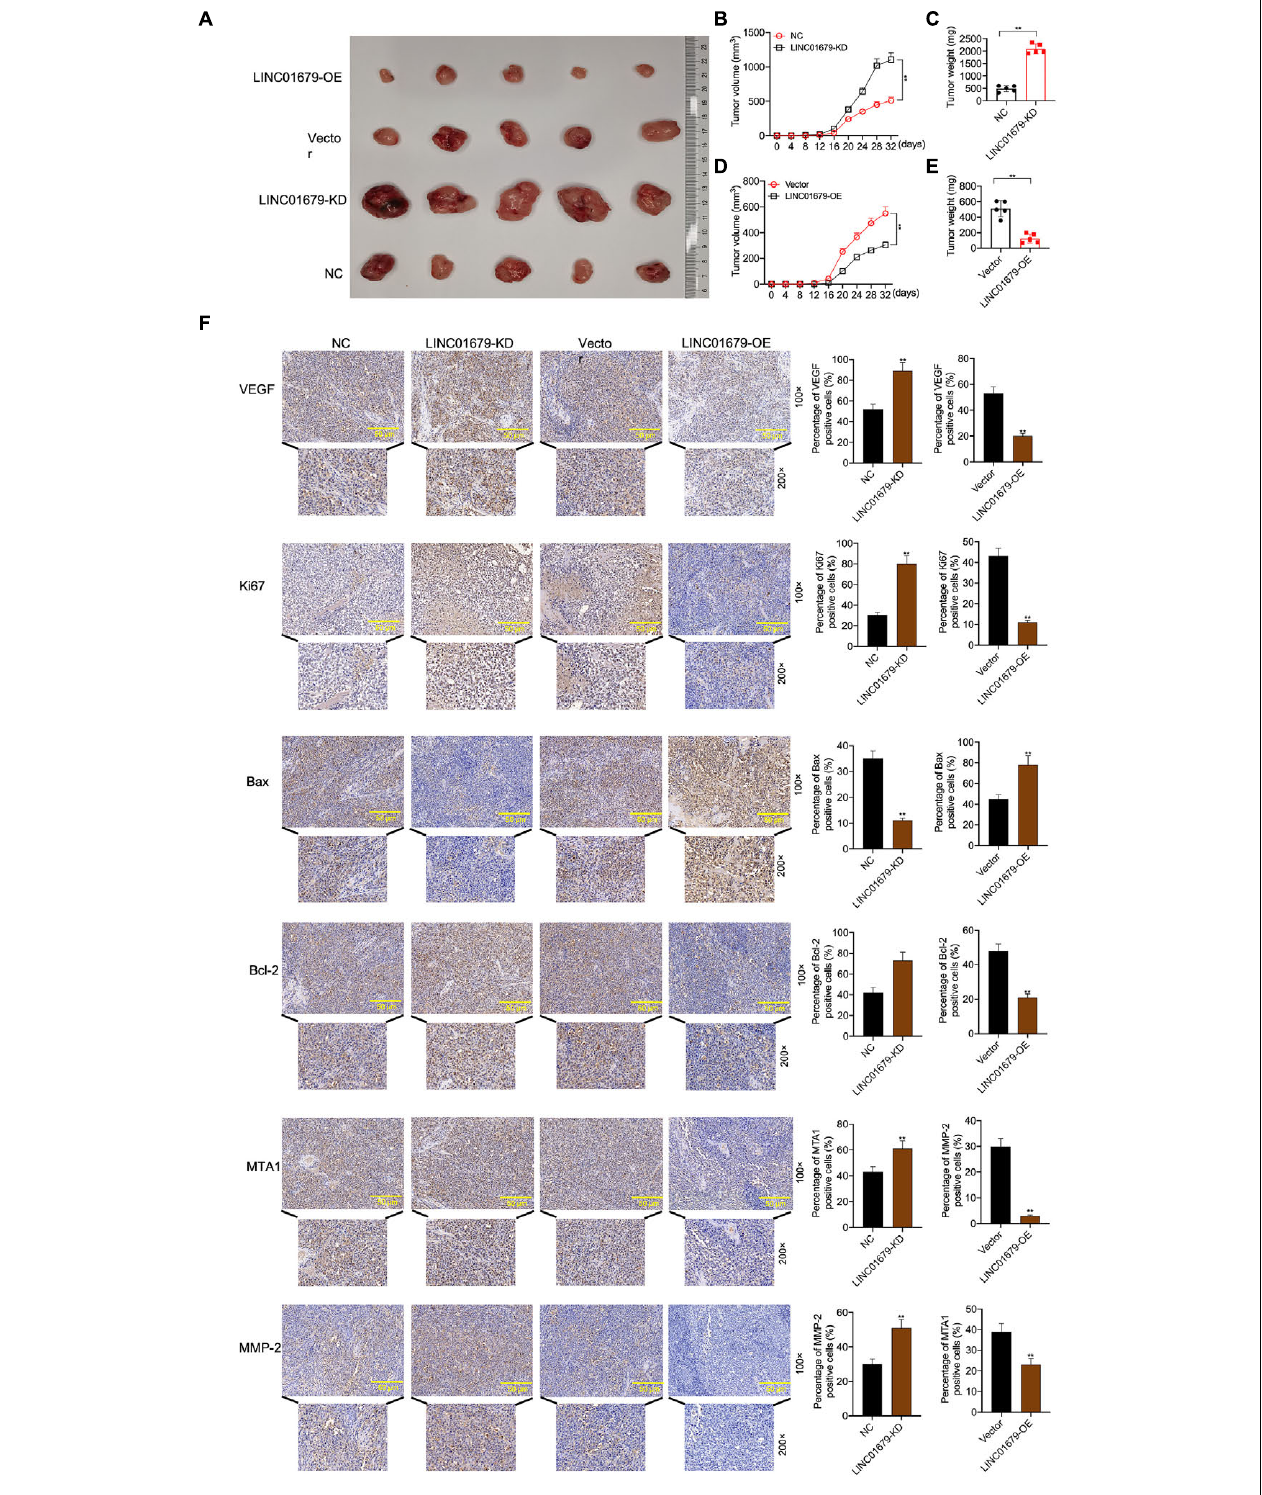
FIGURE 4 | LINC01679 regulated tumorigenesis in vivo. (A) The nude mouse tumor xenograft assay displaying the oncogenicity of LINC01679 inhibition or overexpression ( n = 5). Quantitative analysis on tumor growth (B) and tumor weight (C) after siRNA-LINC01679 treatment. Quantitative analysis on tumor growth (D) and tumor weight (E) after LINC01679-expressing vector treatment. (F) Immunohistochemical staining of VEGF, Ki67, Bax, Bcl-2, MTA1, and MMP-2 in tumor tissues. The experiment was repeated thrice independently; ** vs. NC or vector group, p < 0.01.